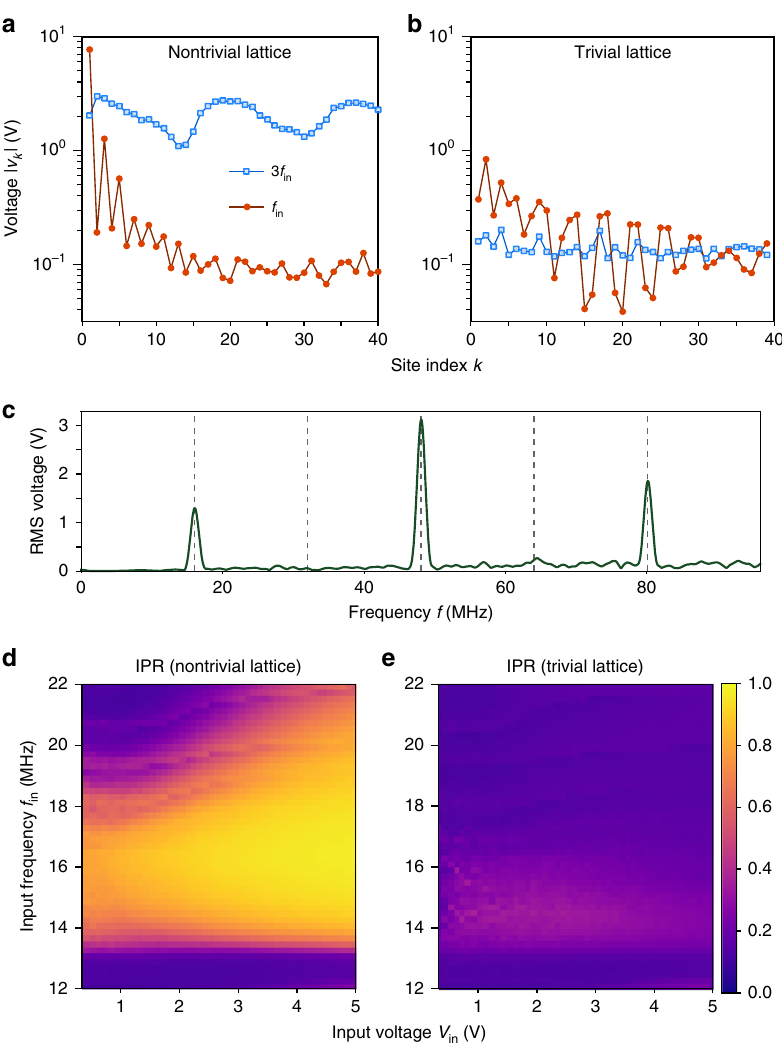
Fig. 2 Experimental observation of harmonic generation in the nonlinear circuit. a , b Magnitude of the fi rst- and third-harmonic voltage signals measured at different lattice sites, for a the nontrivial lattice, which has an SSH-like edge state in the linear limit, and b the trivial lattice, which has no edge state in the linear limit. The sinusoidal input signal, applied at the lattice edge (site 0), has frequency f in = 16 MHz and amplitude V in = 2.5 V. c Measured spectrum at site 3 for the nontrivial lattice corresponding to a . d , e Plot of the inverse participation ratio (IPR) versus input frequency f in and input voltage amplitude V fi rst-harmonic signal in the d nontrivial lattice and e trivial lattice. Here, f in , calculated from experimental measurements of the in is measured in steps of 0.2 MHz, and V in in steps of 0.1